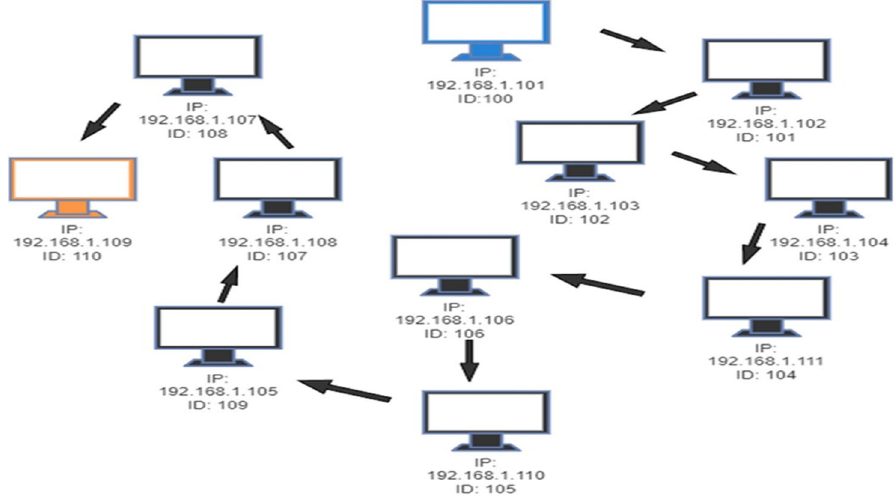
Figure 6. Network structure with di ff erent IP and ID.